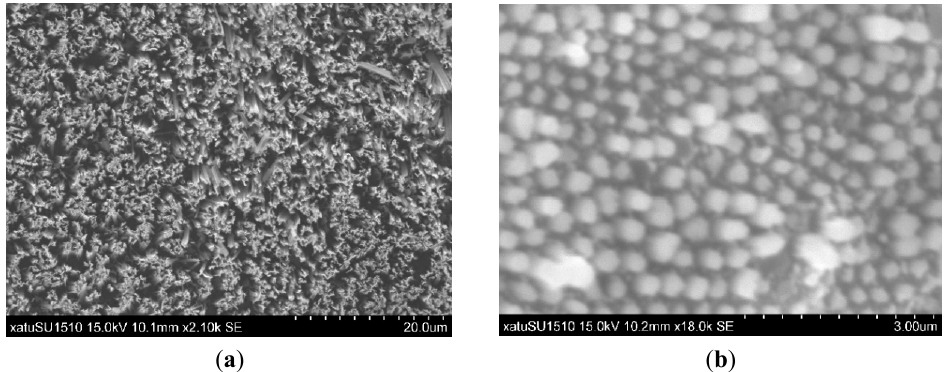
Figure 4. Microstructural images of two differently treated samples after annealing: ( a ) SiNWs fabricated with the randomly distributed Ag film; ( b ) SiNWs fabricated with the spatially ordered mesh Au film.